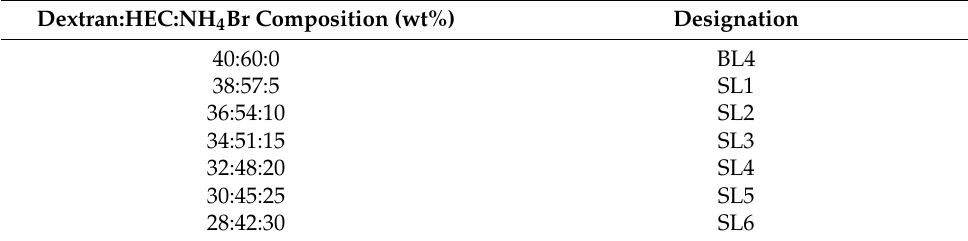
Table 2. Designation for the salted